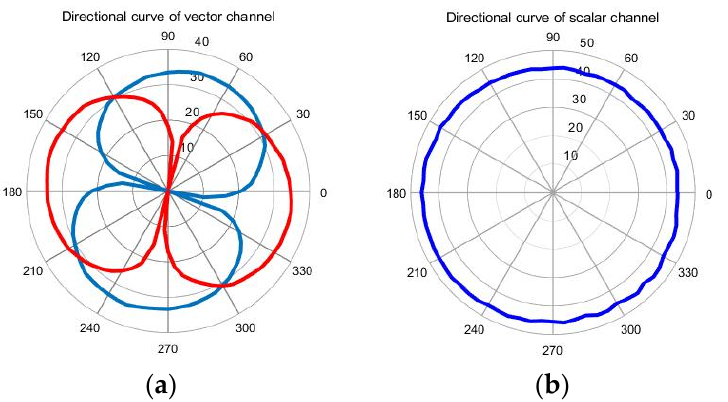
Figure 19. Directivity of composite hydrophone. ( a ) Vector channel at 500 Hz, ( b ) scalar channel.